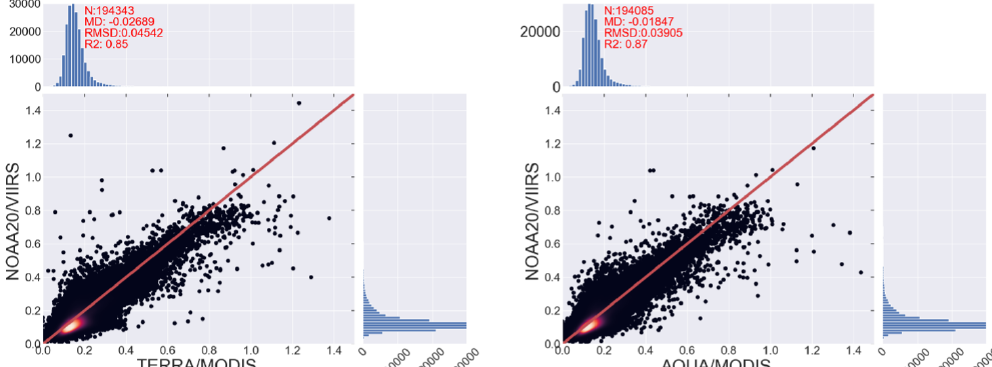
Figure B3. NOAA20/VIIRS vs. MODIS AOD scatter plots of temporal mean AOD over ocean for the DJF